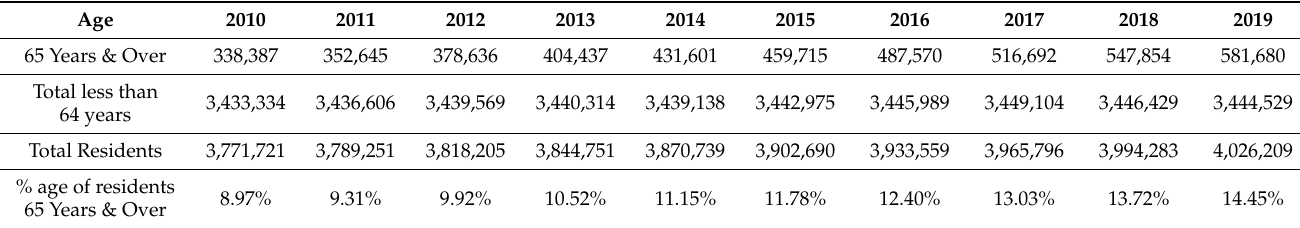
Figure 4. Comparison of Age Group (65 Years and Over versus less than 64 years). Source: Developed for the study. Table 4. Comparison of Age Group (65 Years and Over versus less than 64 years).